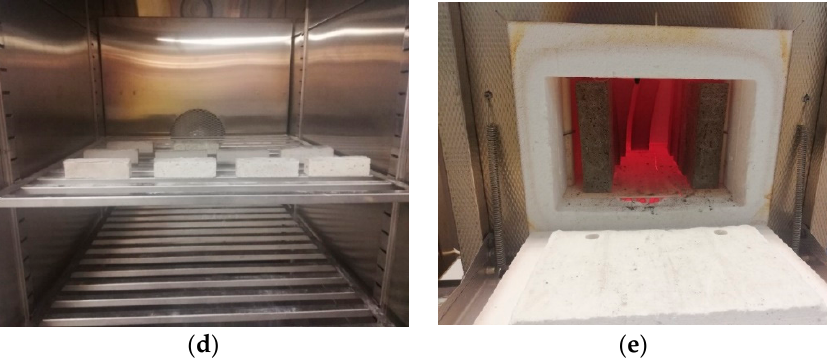
Figure 2. ( a ) UPV measuring at different positions; ( b ) test device used for the drying shrinkage measurements; ( c ) freeze/thaw test; ( d ) carbonation chamber; ( e ) oven used for the high-temperature test.